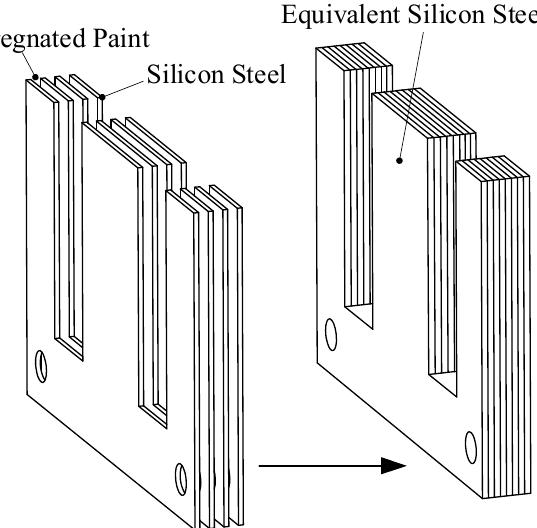
Figure 5. Suspended iron core structure and simplified model.